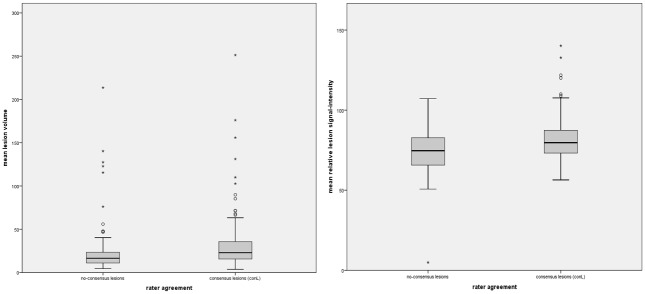
Differences of mean cortical lesion volumes and mean signal intensities between conL and non-consensus lesions.Boxplots in fig 3 display the mean lesion volume (in mm3) and mean signal intensities of CLs that were detected by only one of the two raters (non-conL; left side) vs. CLs that were detected by both raters (conL; right side). Mean volumes and mean relative signal intensities of conL were significantly higher (p<0.05) compared to non-conL.